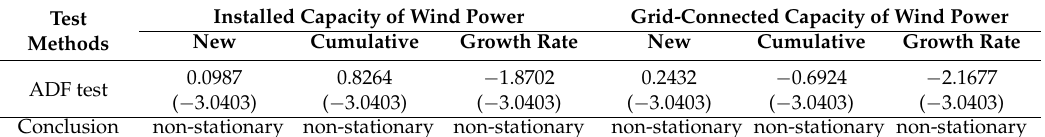
Table 1. Unit root test: